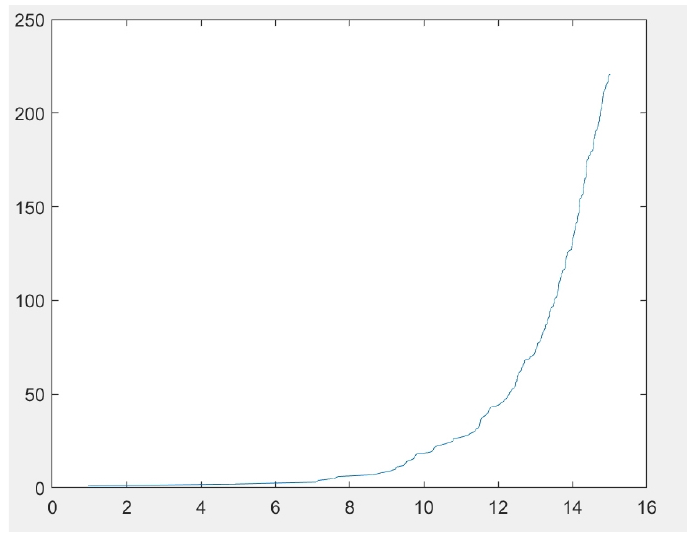
Figure 6. Simulation circulation result.